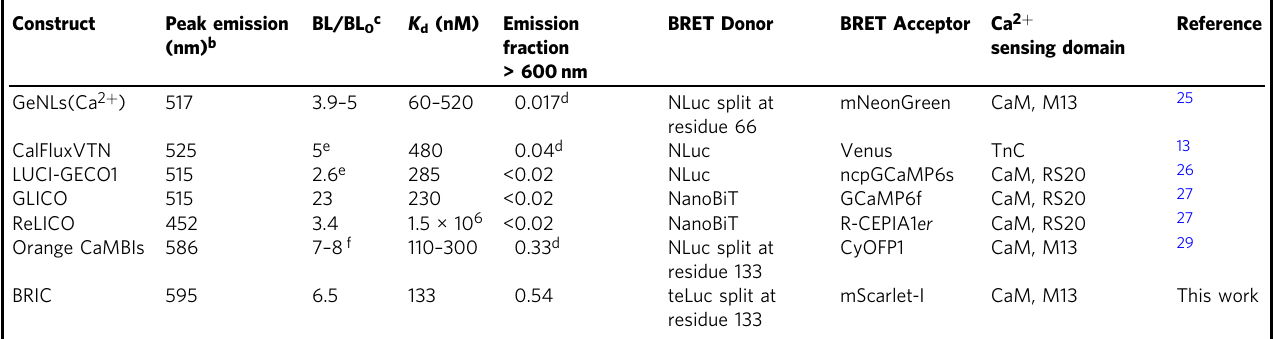
Table 1 Properties of bioluminescence Ca 2 + indicators based on NanoLuc or NanoLuc-derived luciferases a .